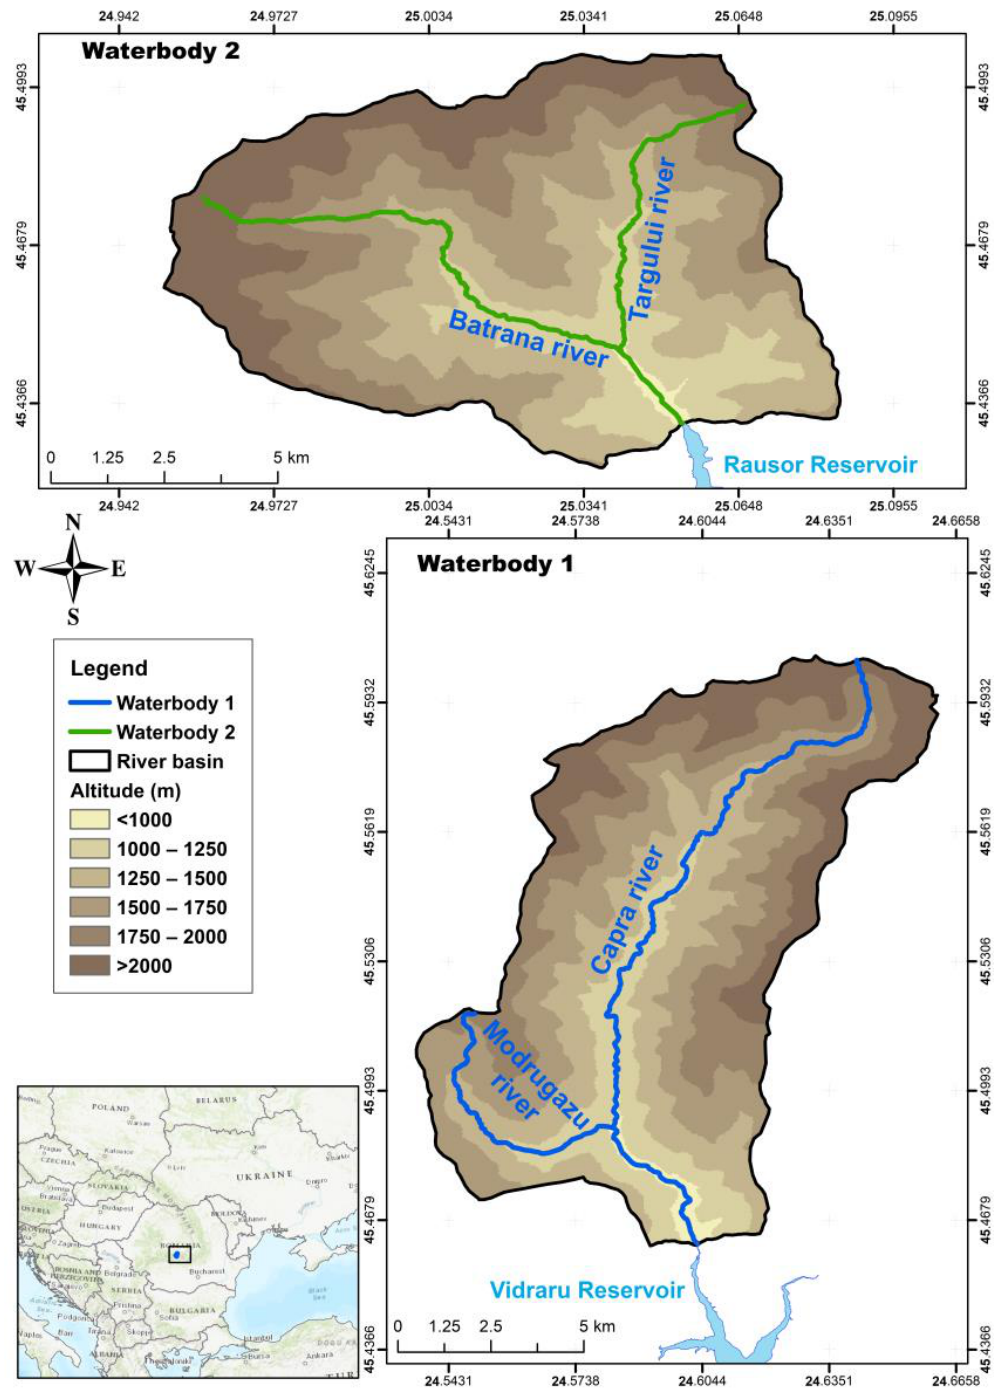
Figure 2. The location of the study areas in Romania.